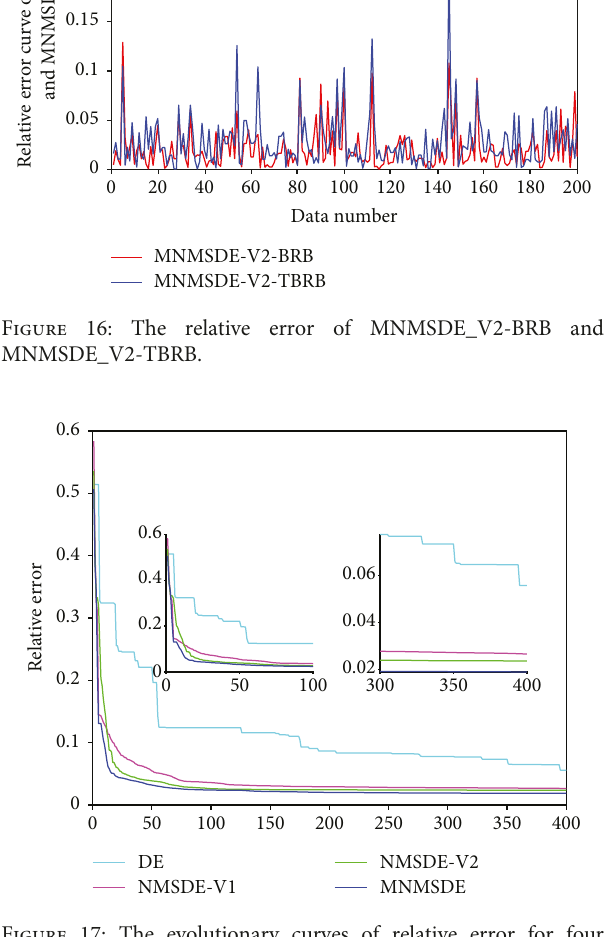
Figure 15: The absolute error of MNMSDE_V2-BRB and MNMSDE_V2-TBRB.